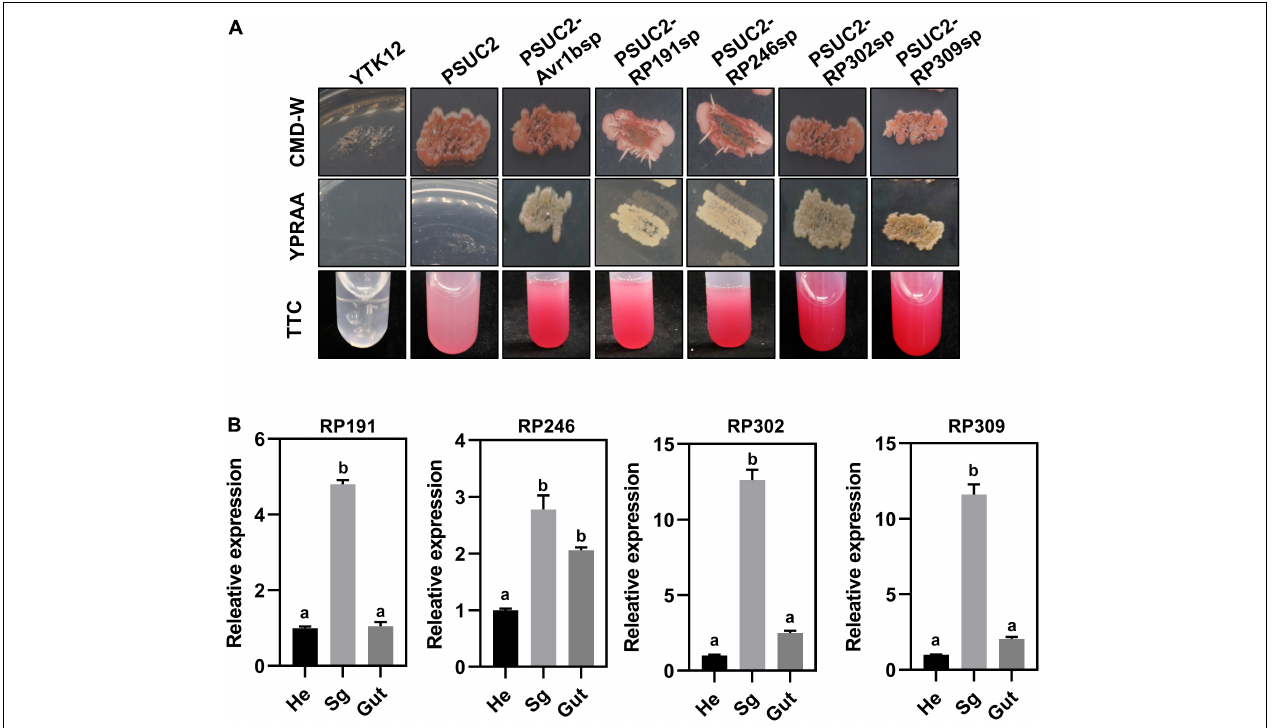
FIGURE 4 | Necrosis-inducing proteins (NIPs) are secreted proteins and are highly expressed in the salivary glands. (A) Detection of N-terminal signal peptide (SP) of NIPs by yeast secretion system. The yeast YTK12 strain carrying PSUC2-Avr1b and NIP signal peptides could grow on CMD-W and YPRAA media, and reacted with TTC to form a red product, indicating the secretion of invertase. YTK12 stain and YTK12 carrying the pSUC2 vectors were the negative controls. (B) Transcription expression patterns of NIPs in different tissue (Sg, salivary gland; Hd, head; Gut, gut). Data were normalized to β -actin gene expression. Different letters above the bars indicate significant